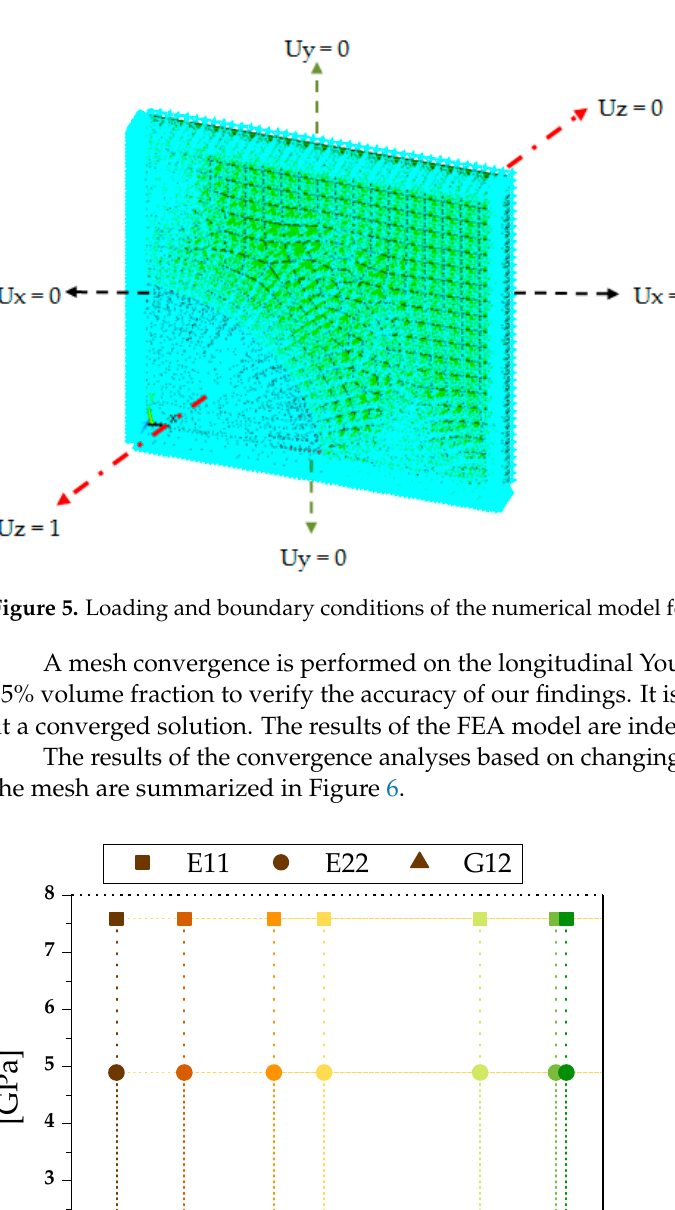
6 of 14 Figure 4. Converged mesh models of composite (RVE dimension) at: ( a ) 15 %; ( b ) 18 %; ( c ) 21 % and ( d ) 24 % of volume fraction of natural fibers. 2.2.4. Loading and Boundary Conditions